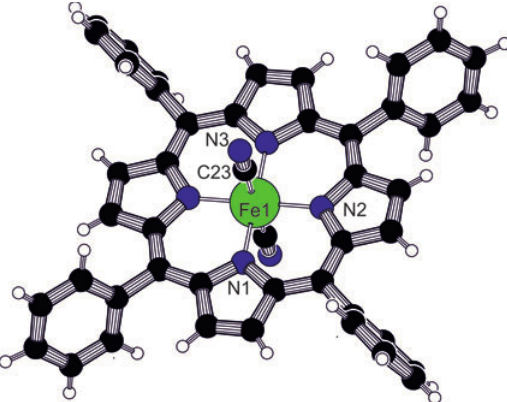
Figure 7 View of the (tpp)Fe(CN) 1980 ). The K(MeCO) groups, is